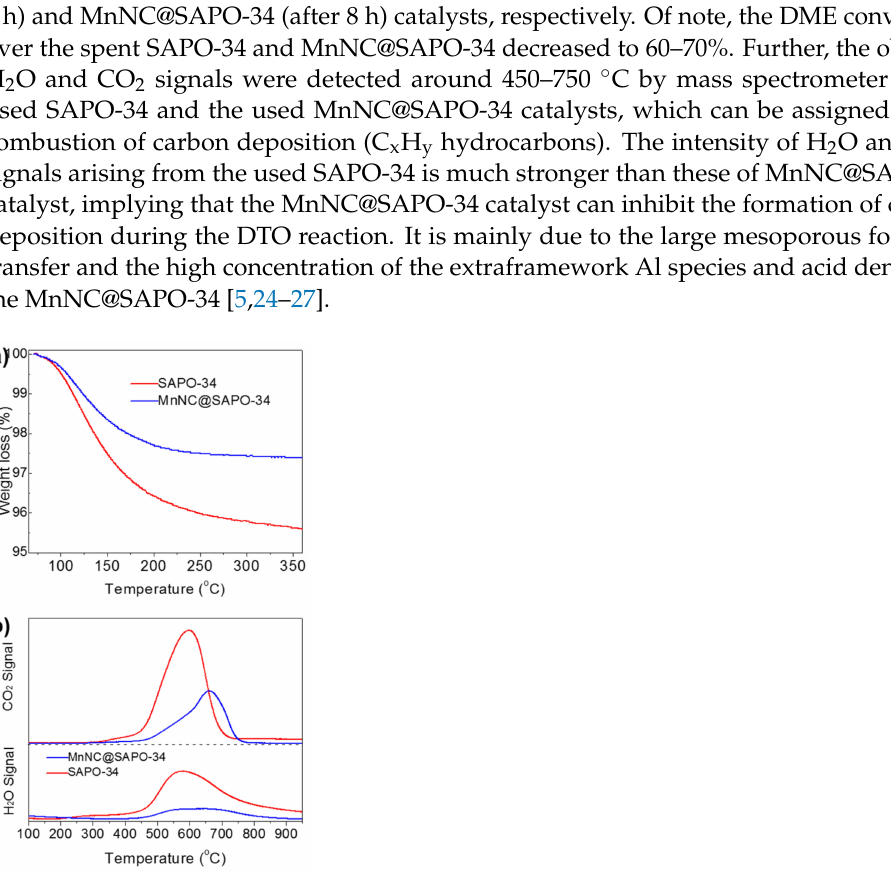
Figure 7. TGA ( a ) and TPO-MS ( b ) of carbon deposition of the spent SAPO-34 (after 2 h) and MnNC@SAPO-34 (after 8 h) catalysts when the DME conversion decreased to